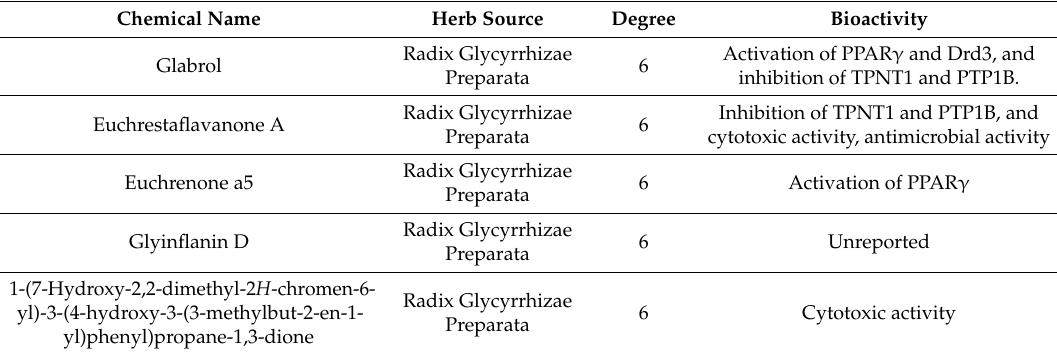
Table 5. Five compounds with the highest degree distribution between compounds and